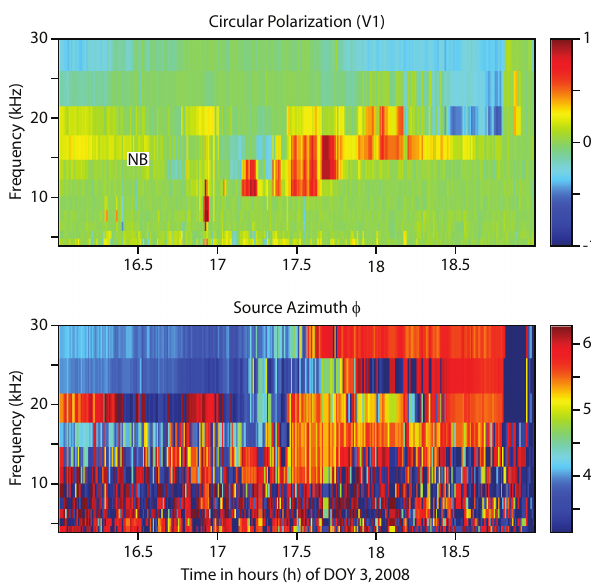
Fig. 3. Circular polarization measurements as calculated from the RPWS instrument for the time interval 16:00 to 19:00 (top panel). Near 15kHz and 17.5h note a transition from blue to yellow-red. The bottom panel displays the azimuth angle in radians of the di- rection to the source in spacecraft coordinates. A distinct change in azimuth angle occurs near 15kHz and 17.5h.